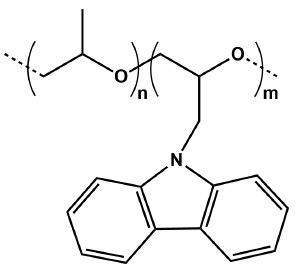
Figure 1. Polypropylene oxide (PPO)- b -poly(9-(2,3-epoxypropyl) carbazole) (PEPK) copolymer structure.